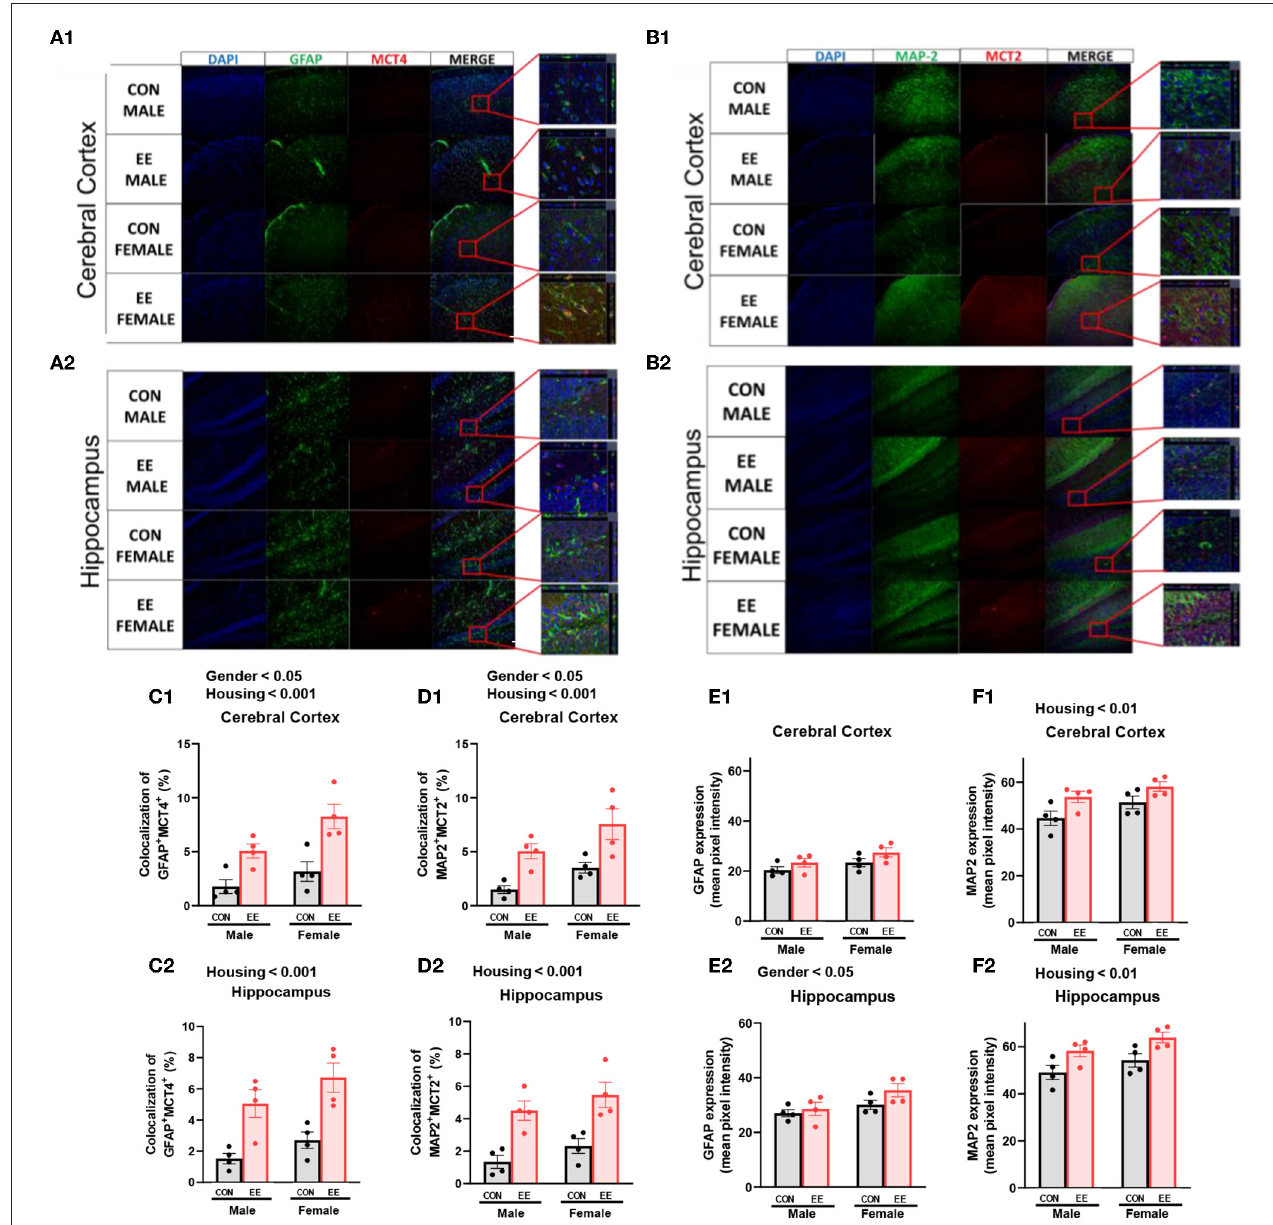
FIGURE 5 | Effects of EE on the uptake of β HB in cerebral cortex and hippocampus under the influence of estrogen. Representative IHC images of (A1 , A2) GFAP + MCT4 + in cerebral cortex and hippocampus and (B1 , B2) MAP2 + MCT2 + in the cerebral cortex and hippocampus ( n = 4 per group). (C1–F1) Quantification of GFAP + MCT4 + and MAP2 + MCT2 + in the cerebral cortex and hippocampus. (C2–F2) Raw intensity of GFAP and MAP2 in cerebral cortex and hippocampus. Two-way ANOVA with Tukey multiple comparison test. Significant sex effect, significant housing effect, and the significant interaction between sex and housing were noted with p -value. Data are means ±